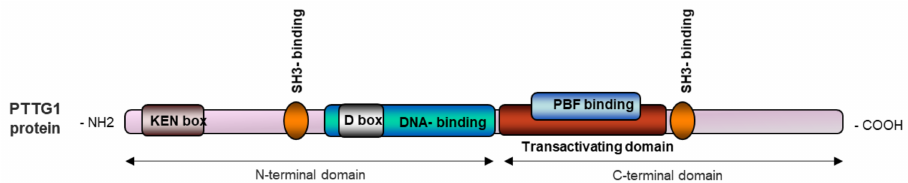
Figure 1. Schematic representation of the PTTG1